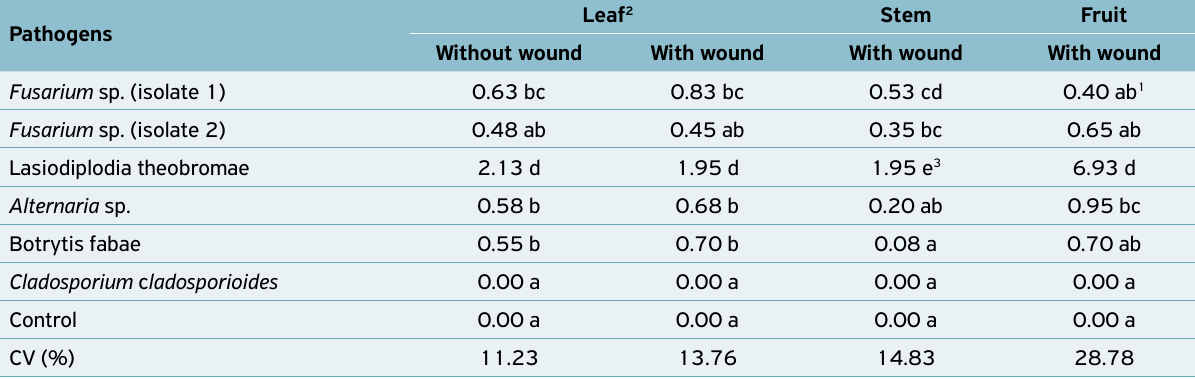
Figure 1. Emergence curve (%) and emergence speed indexes (ESI) of normal Passiflora alata seedlings on Biomix ® commercial substrate, originated from seeds inoculated or not with fungi and obtained from fruit harvested in May 2014 in Campinas, SP. Table 2. Diameter (cm) of the wounds in leaves and fruit of sweet passion fruit, four days after inoculation, and wound length in the plant stem, seven days after inoculation, with or without wound (only on the leaf), of different fungal pathogens, isolated from Passiflora alata